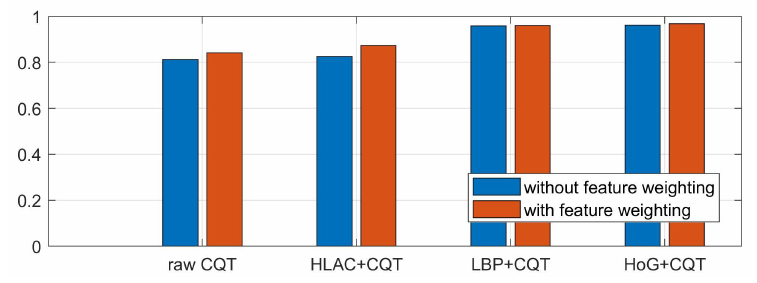
Figure 9. Classification accuracy comparison between w/o feature-enhancing weighting schemes.